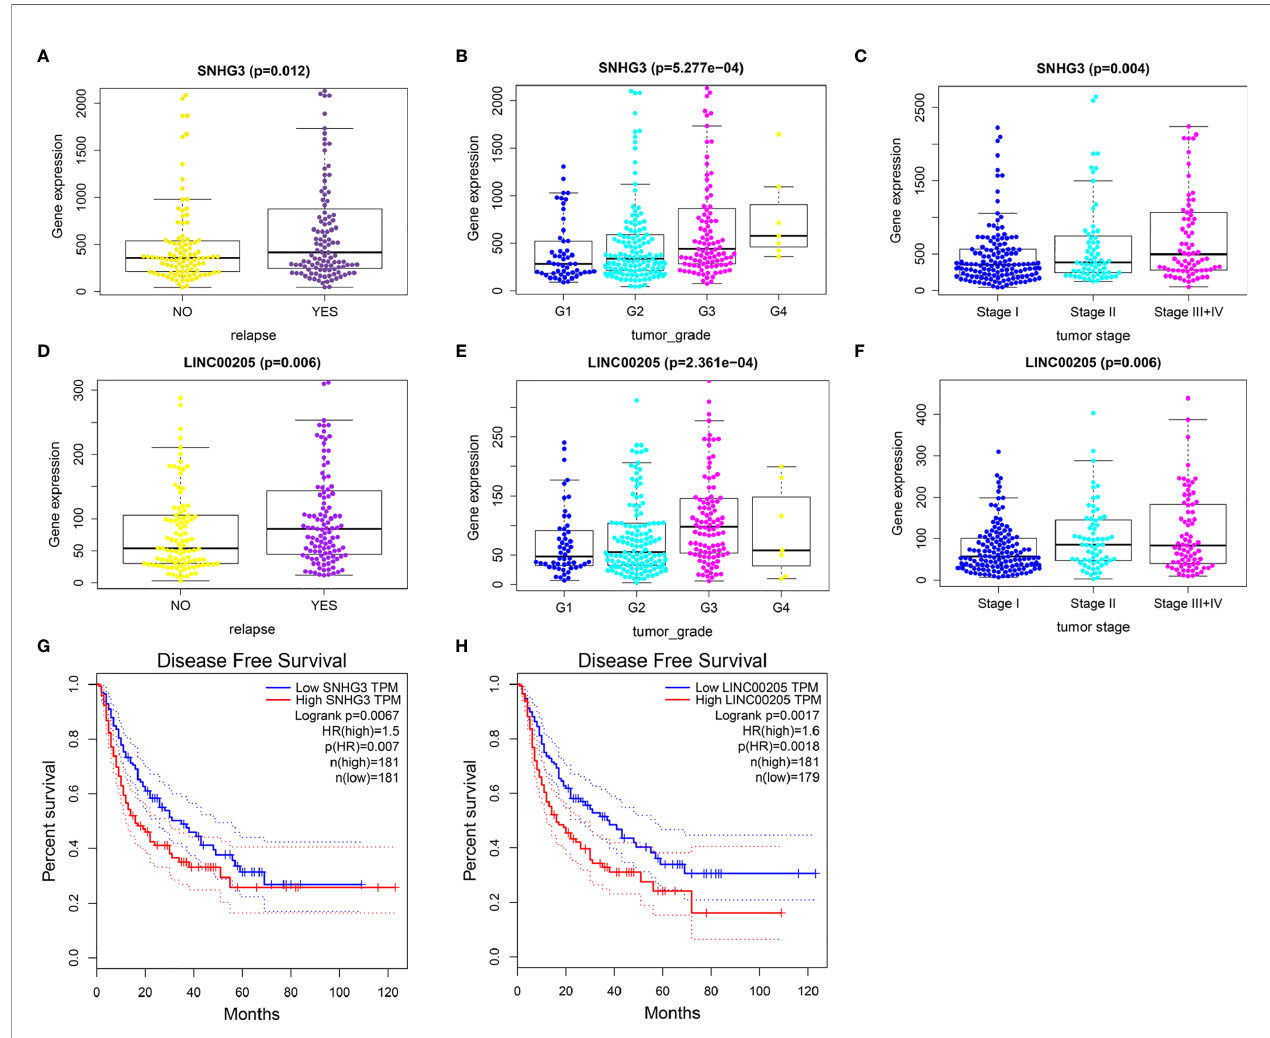
FIGURE 6 | Identi fi cation of relapse-related DELs. (A) The relationship between SNHG3 and HCC recurrence. (B) The relationship between SNHG3 and tumor grade. (C) The relationship between SNHG3 and tumor stage. (D) The relationship between LINC00205 and HCC recurrence. (E) The relationship between LINC00205 and tumor grade. (F) The relationship between LINC00205 and tumor stage. (G, H) Disease-free survival analysis of SNHG3 and LINC00205 preformed using